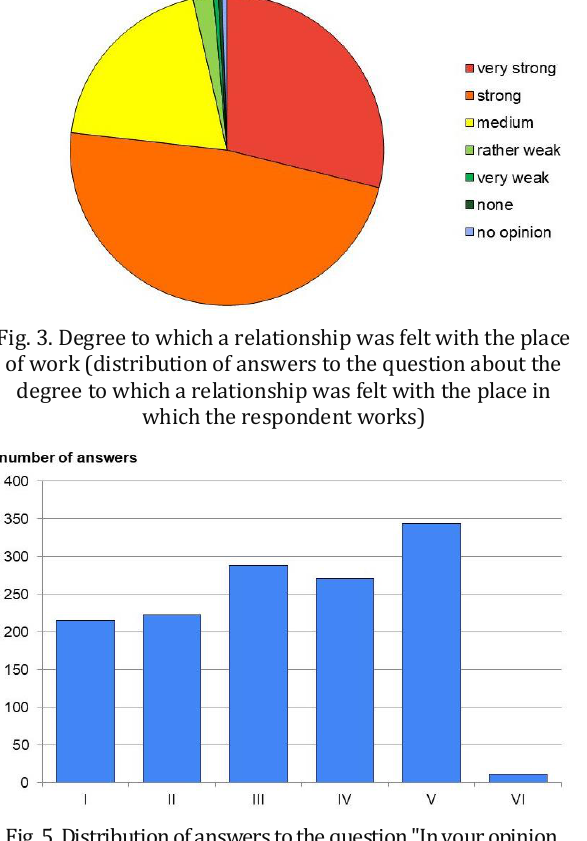
Fig. 5. Distribution of answers to the question "In your opinion, Fig. 4. The distribution of answers between genders to the what affects the strength of the relationship with the place question about the degree of relationship with the place where you work?" Explanations to the chart: I – I was born where the respondent works here; II – there are places here which are important for me; III – my family that I feel connected to lives here; IV –